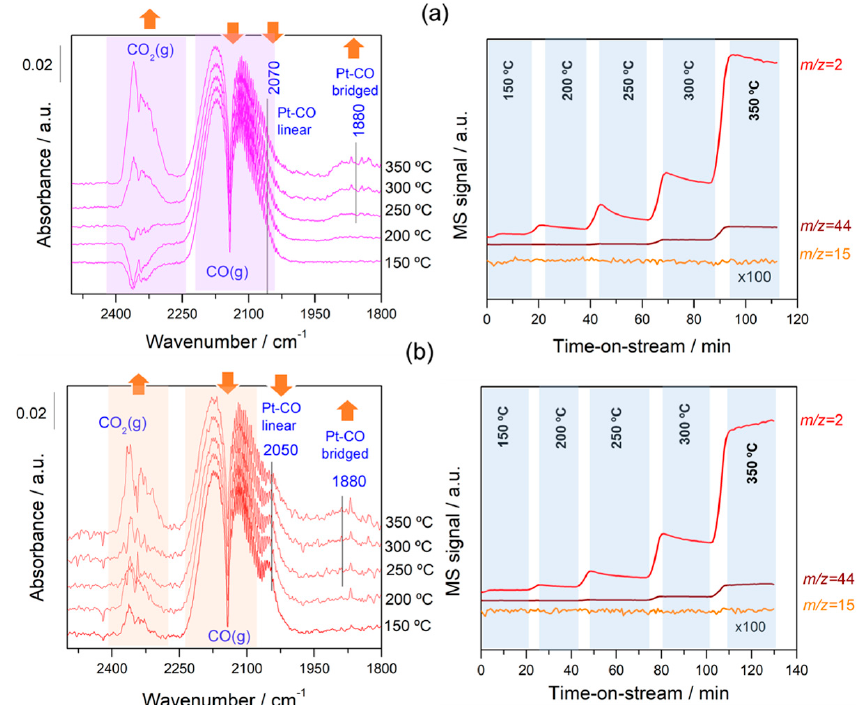
Figure 6. Evolution of different DRIFT spectra and gas-phase species produced as a function of the WGS reaction temperature for the samples ( a ) Pt/C and ( b ) Pt–Na/C. The reference spectrum was recorded after activation at 150 °C. The amount of H 2 , CO 2 , and CH 4 was measured with a mass spectrometer located at the exit of the DRIFTS cell.